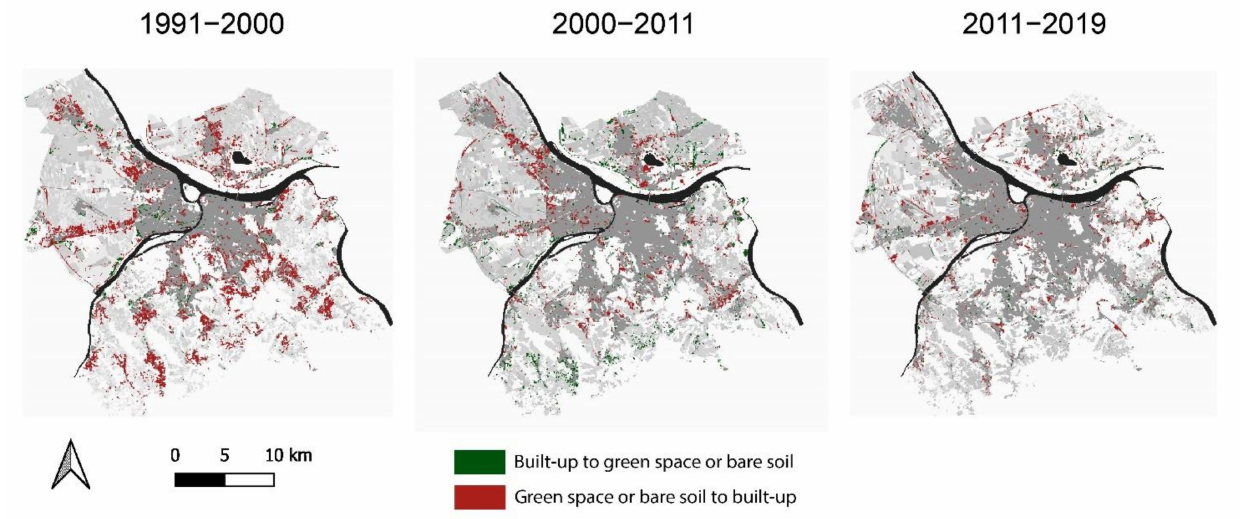
Figure 7. Belgrade’s land cover change maps for the last three